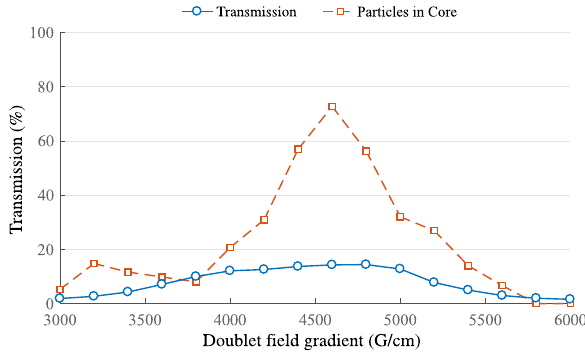
FIG. 6. Plot of beam transmission and beam quality for lithium ions based on a design optimized for deuterons.